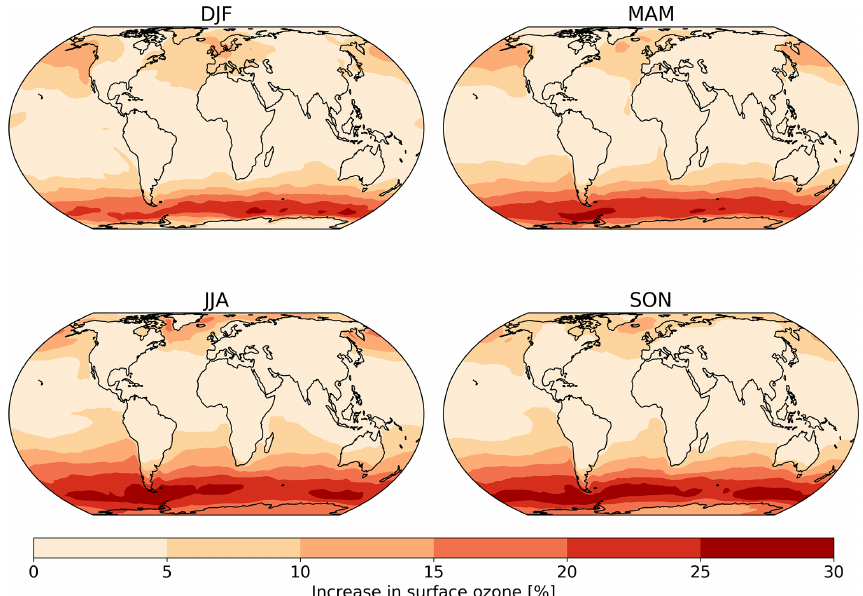
Figure 8. The absolute seasonal surface ozone mixing ratio change for 2014 between the model runs using the default (constant) and new (variable) parameterization for r c